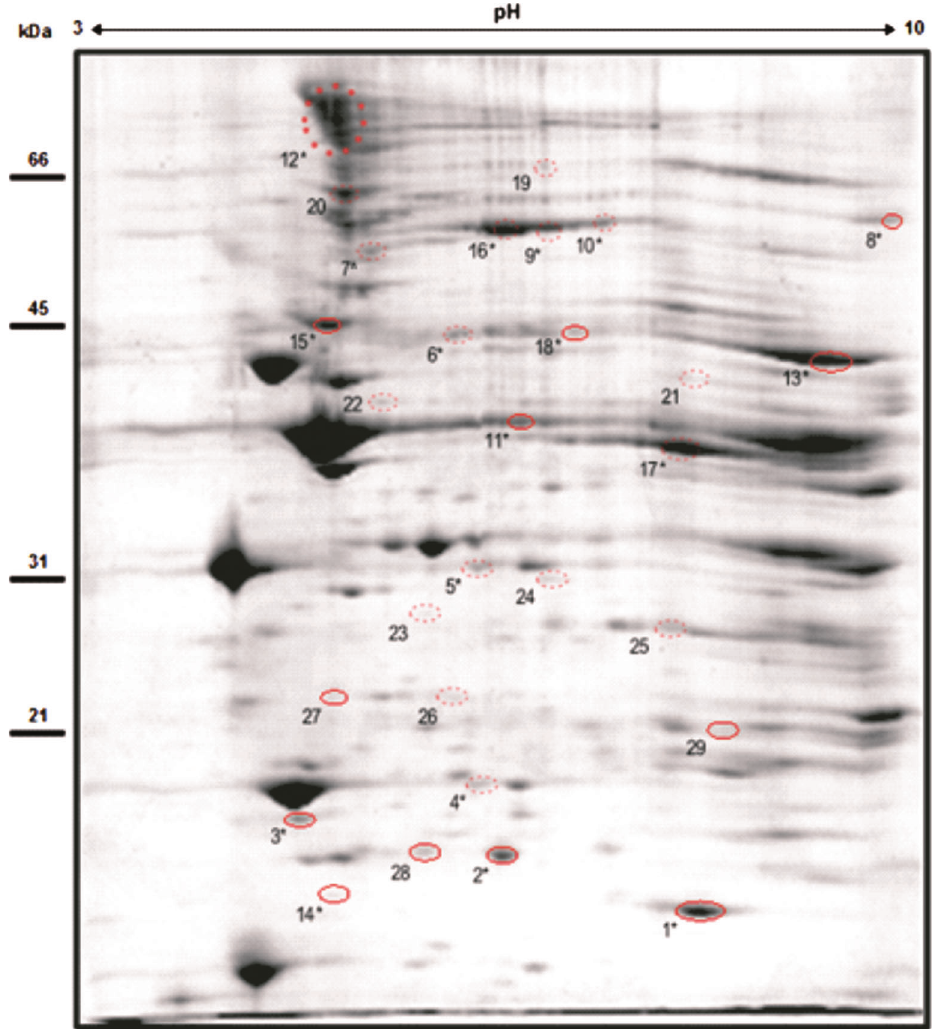
Figure 2. Representative 2-DE gel of the left ventricle protein extracts from high running performance (HRP) group. The spots numbered and surrounded are statistically different (P o 0.05) between groups. The dotted circles show the spots with increased expression and complete circles show the spots with lower expression in the HRP group compared to the low running performance group. *Proteins identi fi ed by mass spectrometry (MS) and MS/MS.